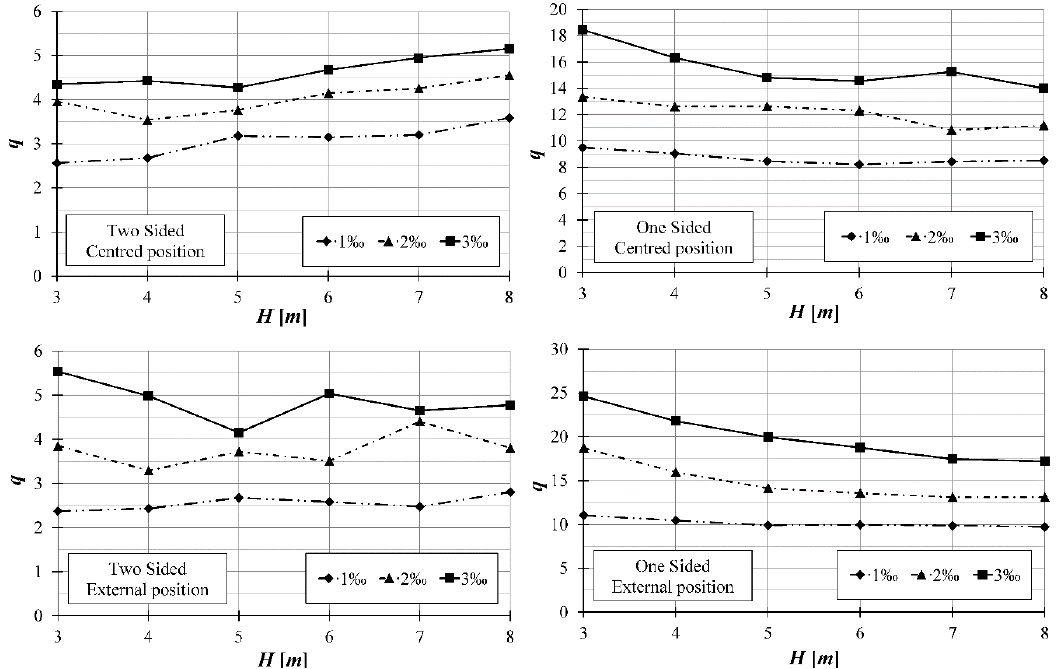
Figure 10. q factor versus height H — α =7.5°, Spectrum A2 , GFRP material.